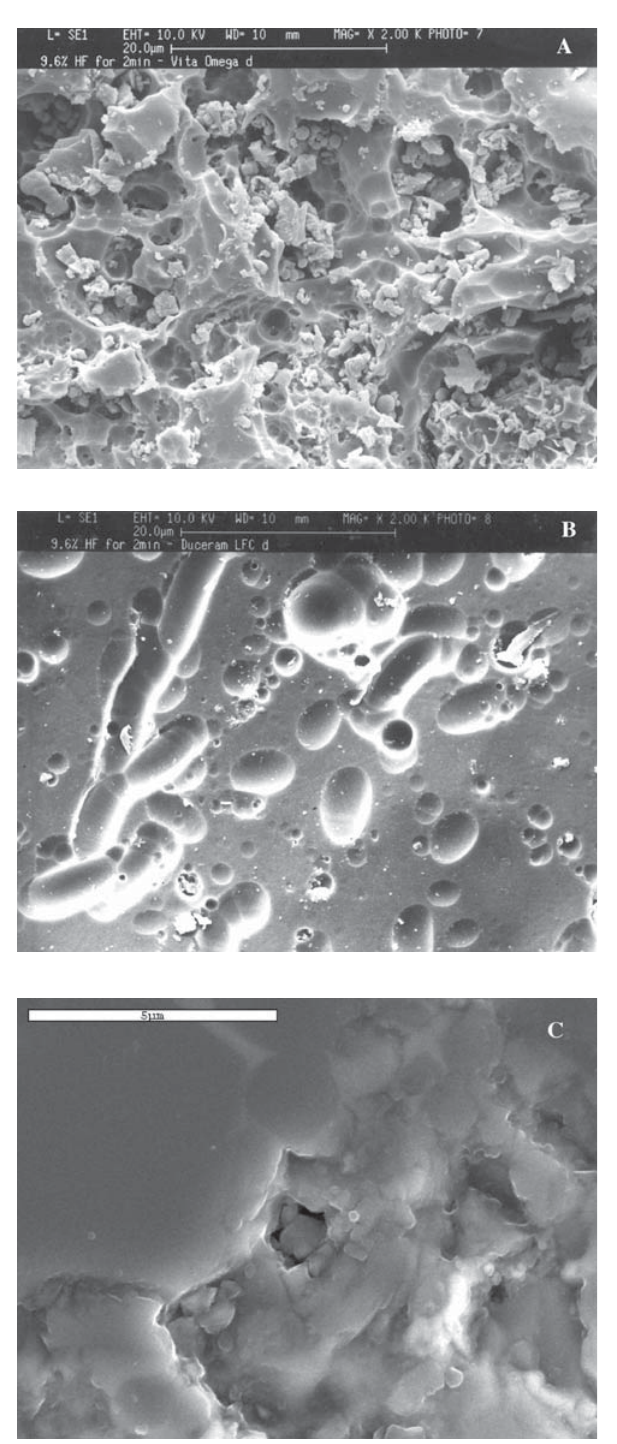
FIGURE 1- Photomicrographs of HF-etched ceramics. (A) Vita Omega dentine ceramic (Vita Zahnfabrik, Bad Sackingen, Germany), a leucite based feldspathic ceramic. (B) Duceram-LFC ceramic (Ducera, Rosbach, Germany), a single-phase low-fusing glass. (C) In-Ceram Zirconia ceramic (Vita Zahnfabrik, Bad Sackingen, Germany), a glass-infiltrated zirconia reinforced alumina-based ceramic. HF etching produces a very aggressive effect on the surface of most acid-sensitive ceramics (A). The acid effect is reduced for either single-phase (B) or high crystalline content ceramics (C). From Della Bona and Anusavice 25 , 2002.